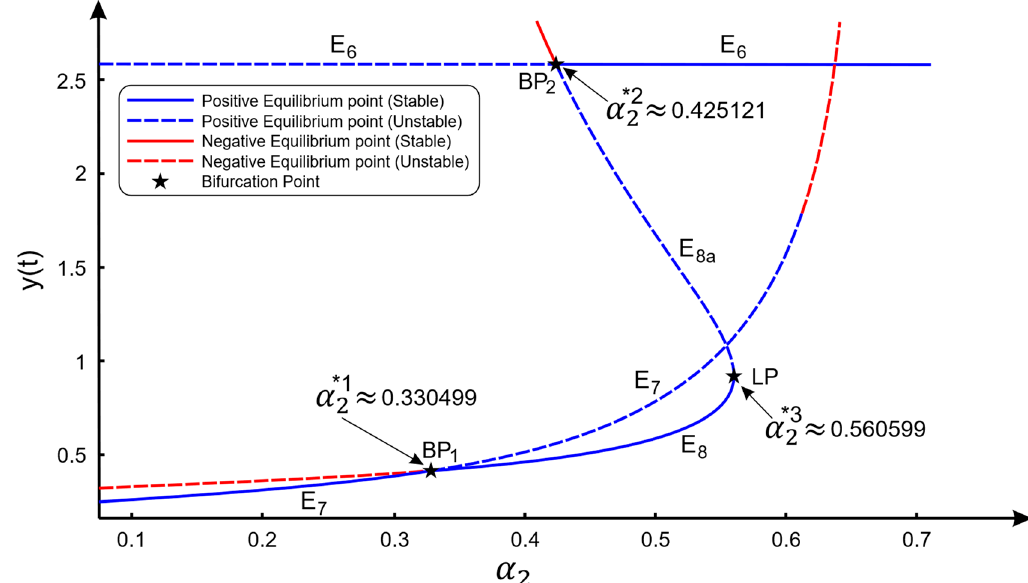
Figure 2. Equilibrium state density of predator-1 as function of competition rate of predator-2 ( 2 α ).